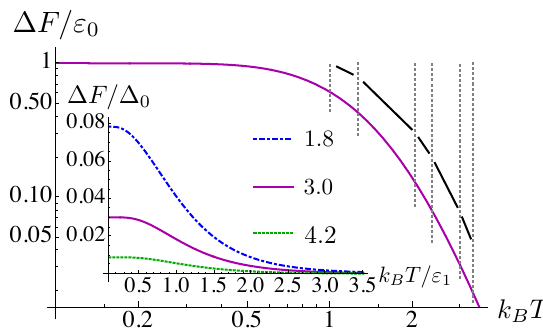
Figure 4: The parity disparity ∆ F = F − − F + normalized by the ground state energy level (cid:34) as a function of temperature normalized by the excited energy level (cid:34) 0 main figure (log-log axes) we show the parity disparity for a vortex-vortex separation of R /ξ = 3.0. The CdGM levels are indicated with gray dotted lines, and the algebraic temperature law T − n , predicted in Eq. (14), is shown in black. The inset shows the parity disparity for three values of the inter-vortex separation, with values of R /ξ given by the